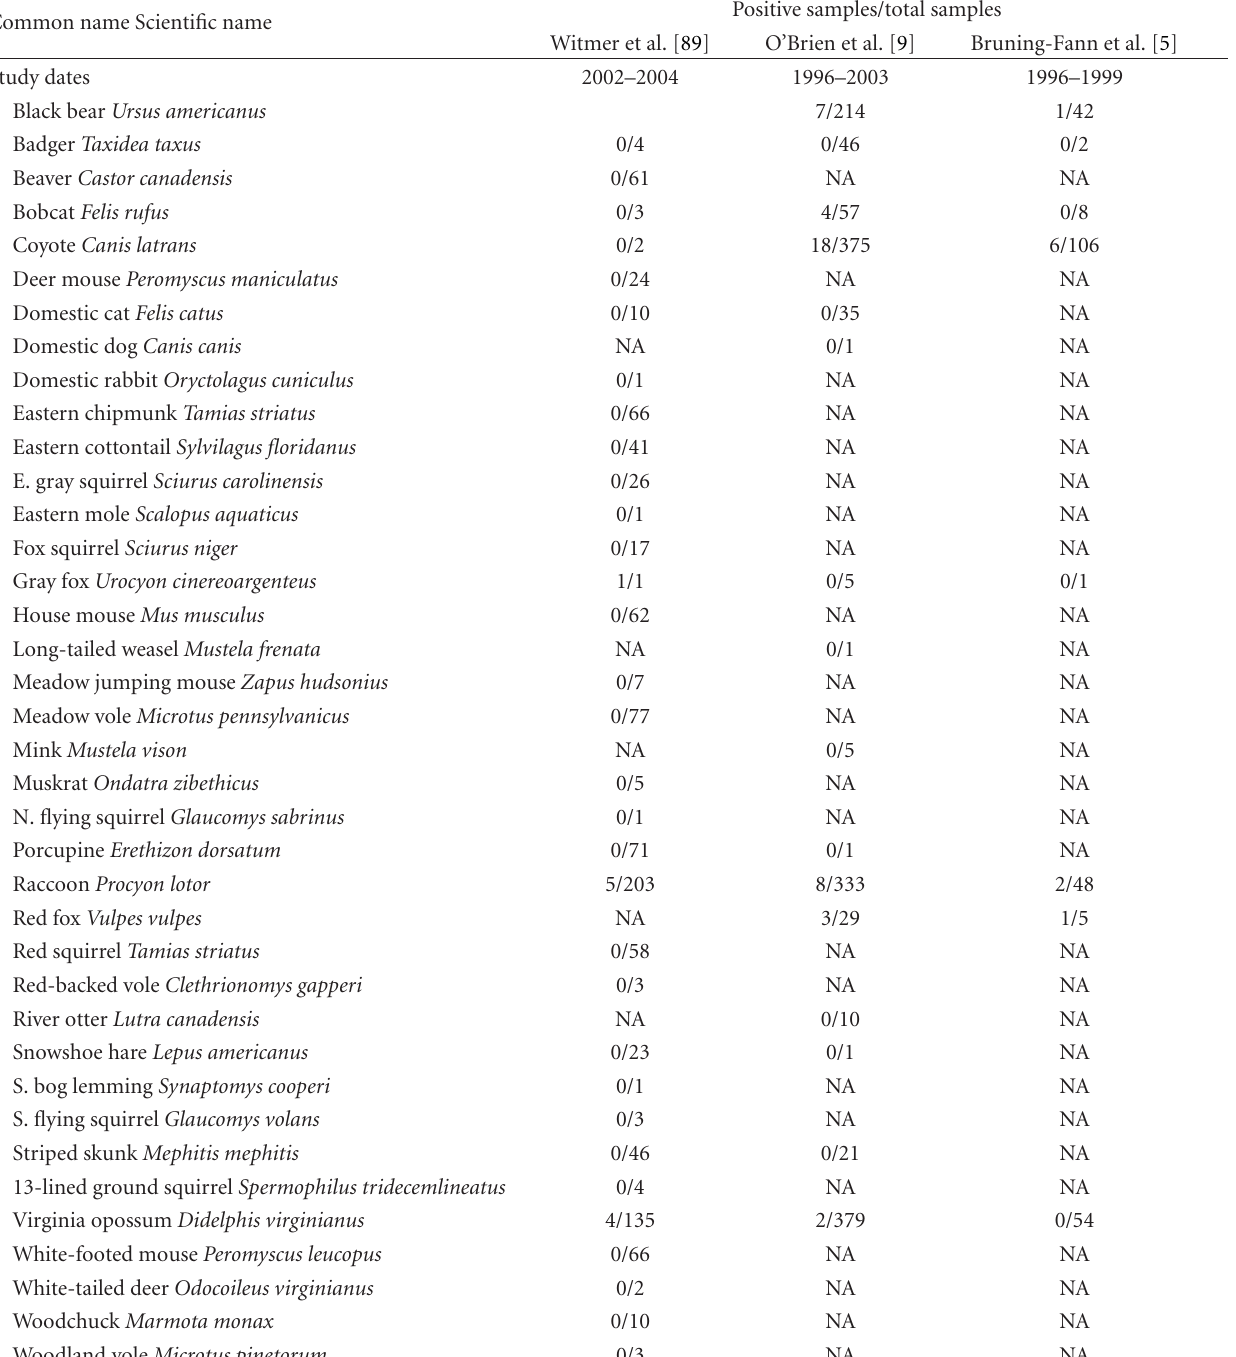
Table 2: Surveillance studies identifying all species collected and analyzed that had cultures that were tested for Mycobacterium bovis in North